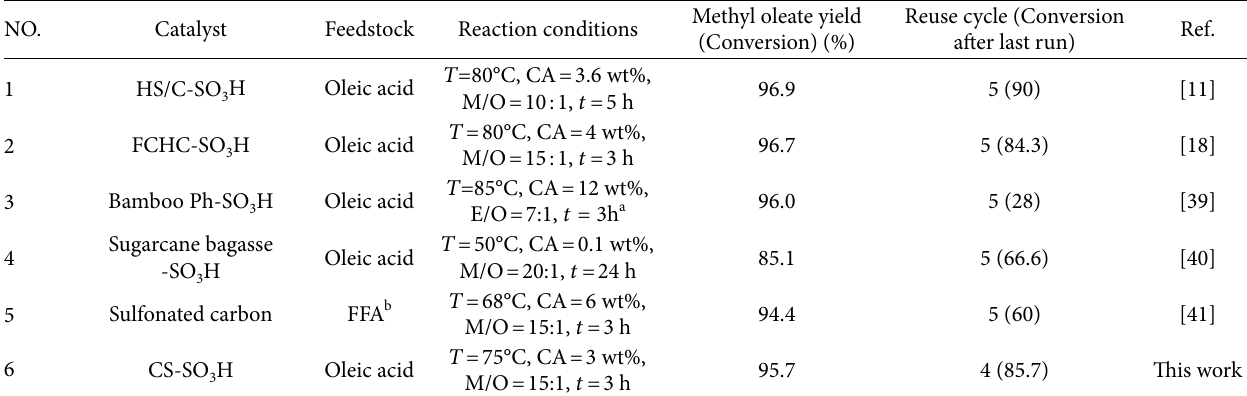
a The reaction substrates are ethanol and oleic acid. b FFA denotes free fatty acids.